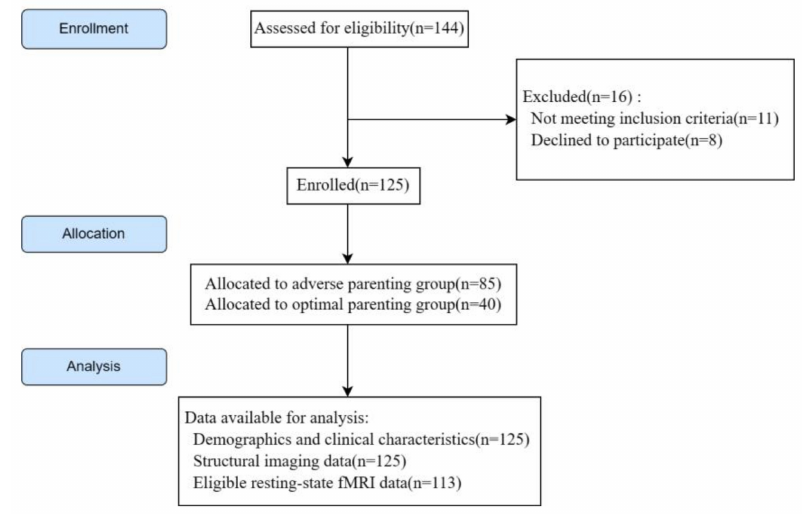
Figure 1. Flowchart representing the procedure of study design and